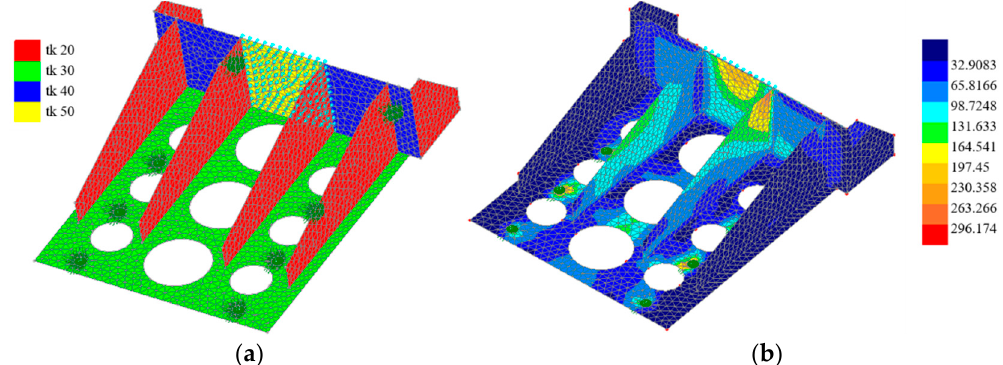
Figure 21. Finite Element Model (FEM) model of the anchorages: ( a ) thickness color map, and ( b ) stress field (MPa) according to the Von Mises criterion.